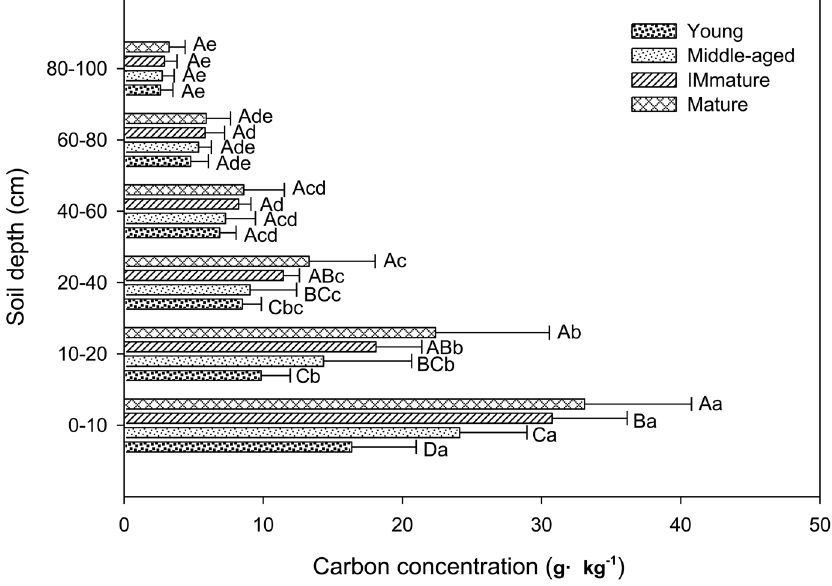
Figure 3. MSOC concentrations at different soil depths in the P.tabulaeformis forests. Different uppercase letters indicate a significant difference between age groups in the same depth ( p , 0.05), different lowercase letters indicate a significant difference between different soil depths within-stand ( p , 0.05). Error bars standard deviation ( SD ). doi:10.1371/journal.pone.0094966.g003 PLOS ONE |